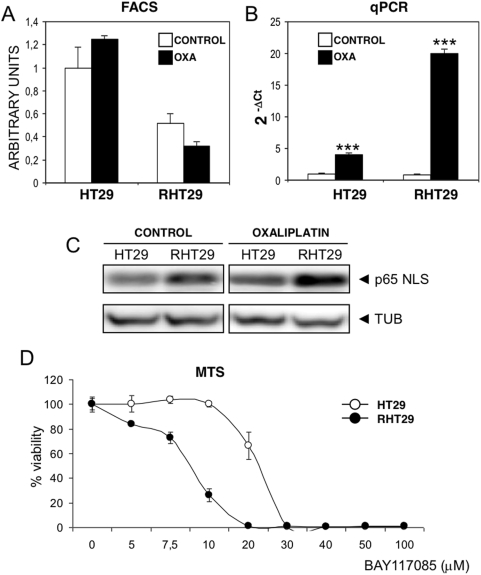
Modulation of FasL expression in HT29 and RHT29 cells lines.FasL expression was detected in HT29 and RHT29 cell lines treated or not with oxaliplatin 10 µM by A) FACS analysis of its surface expression or B) qPCR of its mRNA levels. C) NF-κB p65 was detected by Western Blot by the use of an antibody that recognizes the nuclear localization signal (NLS) epitope. Tubulin expression was used as endogenous control. D) Sensitivity of both cell lines to the inhibition of the NF-κB pathway was measured by an MTS assay in which cells were treated with different doses of BAY117085, a known inhibitor of IKK activation. Values that are significantly different between control and treated group by ANOVA analysis are indicated by ***p<0.0001. OXA: oxaliplatin.